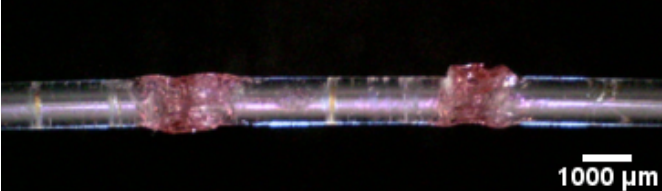
Figure 3. Example of a fiber with two annular cavities. The initial trenches were filled with the gel solution of solvent, polymer, and Platinum Octaethylporphyrin (PtOEP) and left for 1 day to solidify. The fiber is 1mm in diameter, and the separation of the cavities is 5mm.